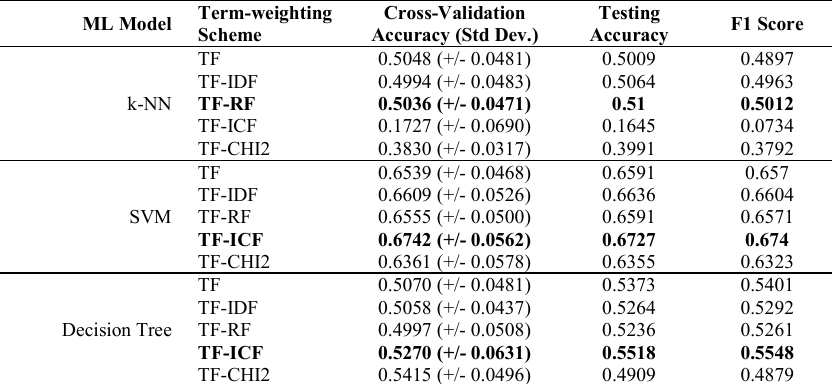
Fig. 4 The result of the F1 score for each term-weighting scheme using uni-gram TABLE 2 T ERM - WEIGHTING S CHEME R ESULT IN U NI -G RAM AND B I -G